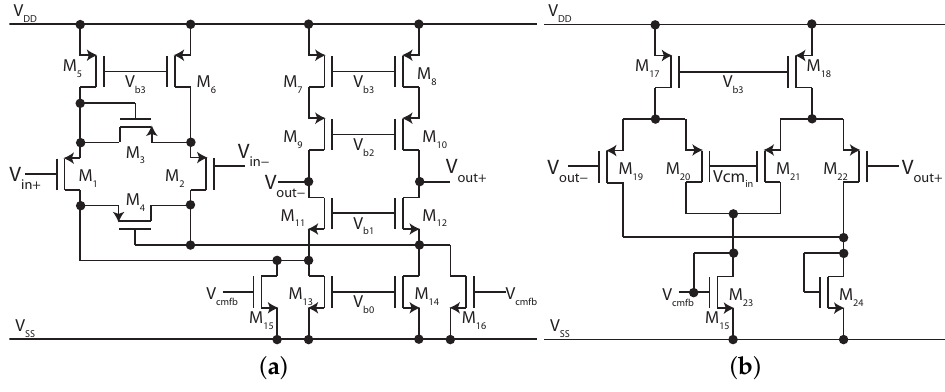
Table 4. These are for a triple well, 0.18 µ m CMOS process with MIM capacitors, and suitable sizing is a trade-off between the bandwidth, matching and noise [19].